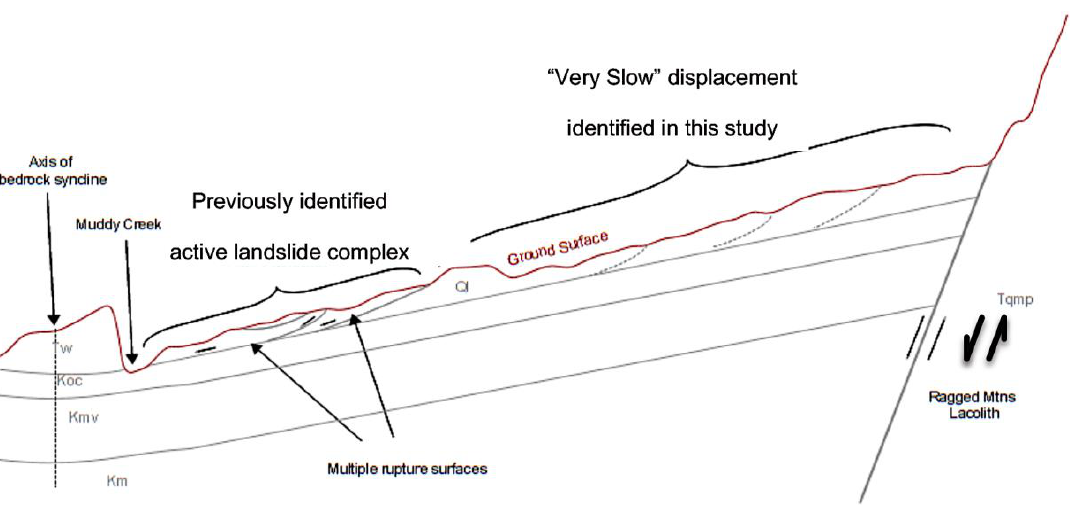
Figure 2. Interpreted cross section of slope near the Ragged Mountains with regional geologic units of Wasatch Formation (Tw), Ohio Creek Sandstone (Koc), against the tectonically active Ragged Mountains Lacolith (Tqmp) (modified from [2]).